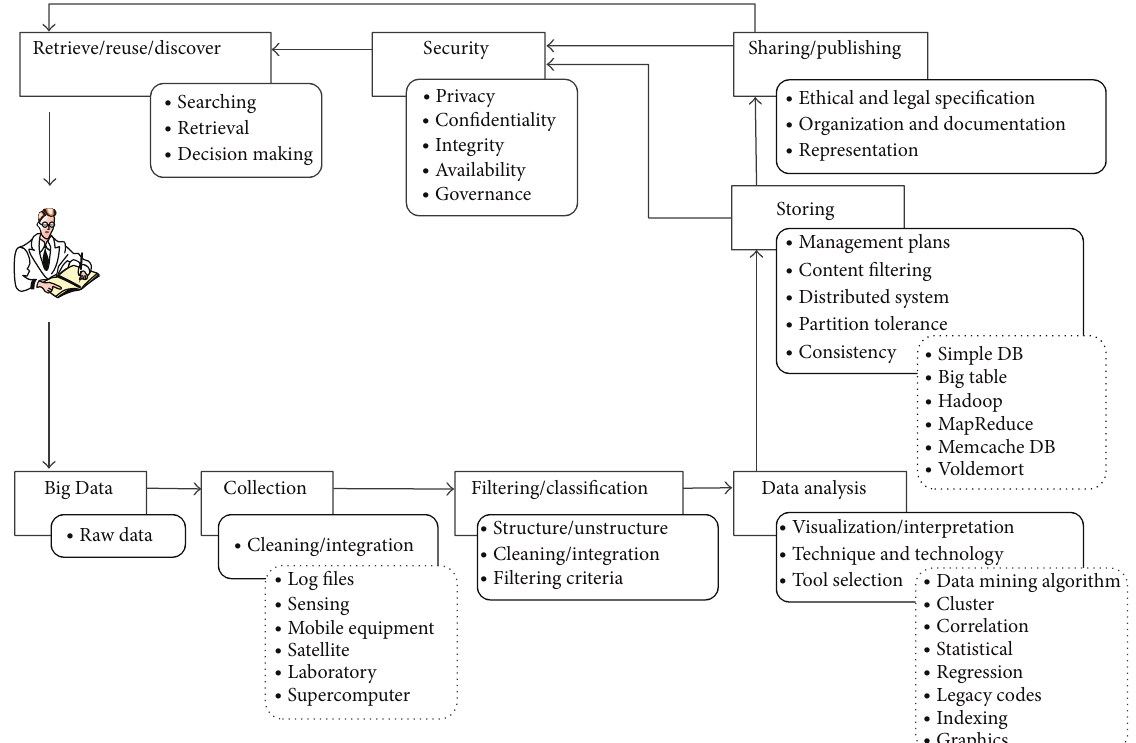
Figure 6: Proposed data life cycle using the technologies and terminologies of Big